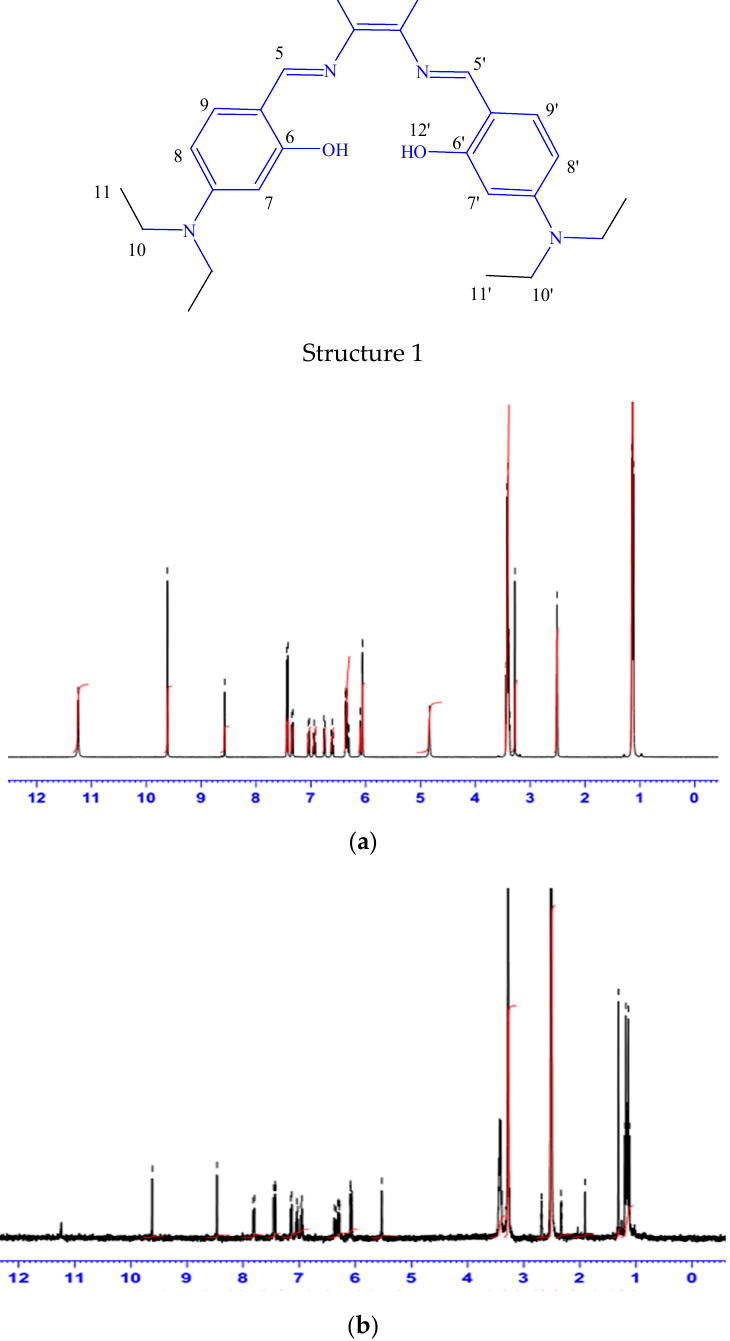
Figure 1. The 1 H-NMR spectroscopy of the prepared H 2 L imine ligand ( a ) and its PdL complex ( b ).